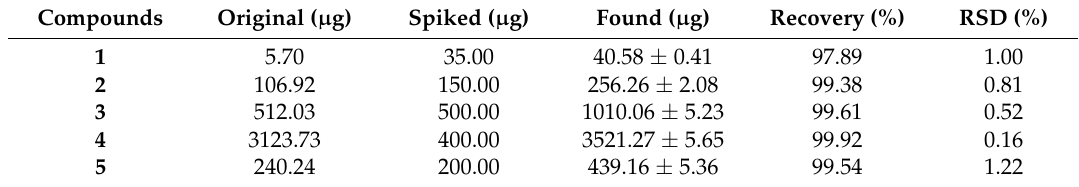
Table 5. Accuracy of HPLC method for the determination of the five less polar ginsenosides. Compounds